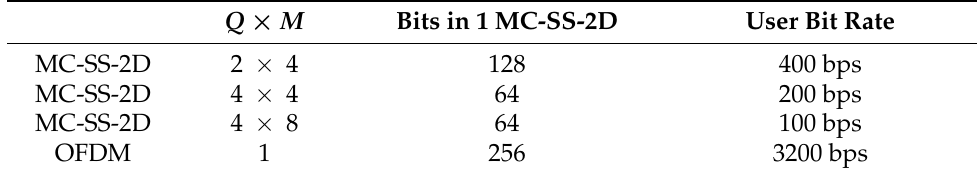
Table 1. Signals